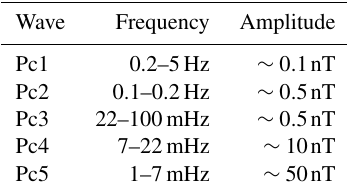
Table 1. ULF waves in the